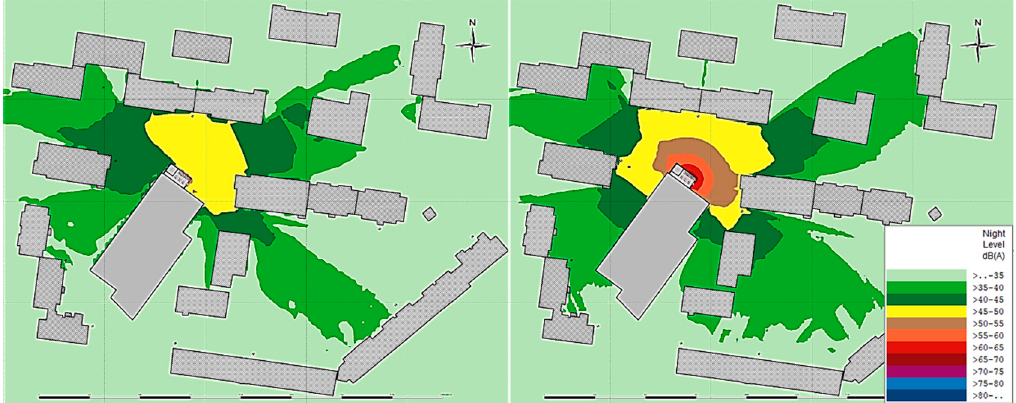
Figure 13. Ln—Scenarios 1, 2, 3 and 4 ( left : 4 m, right : 10 m).